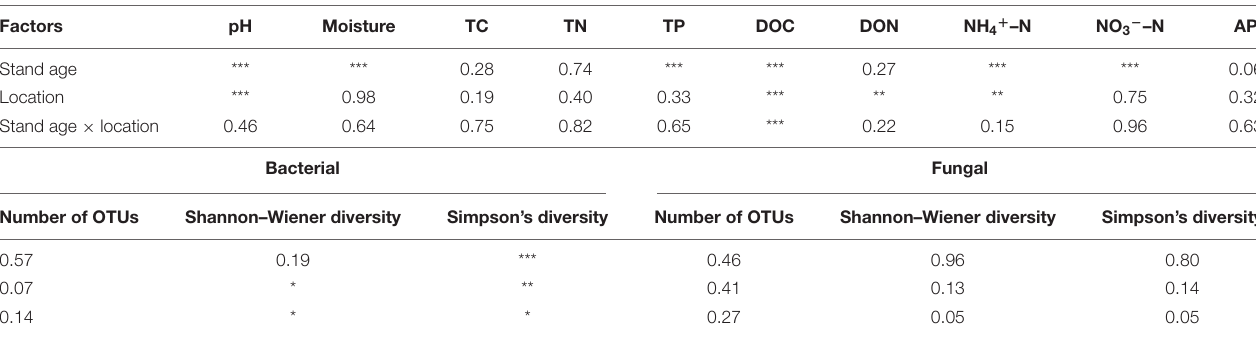
TABLE 1 | Results of two-way analysis of variance (ANOVA) showing the effects of stand age, location (rhizosphere and bulk), and their interaction on the soil properties, and bacterial and fungal diversity indices.